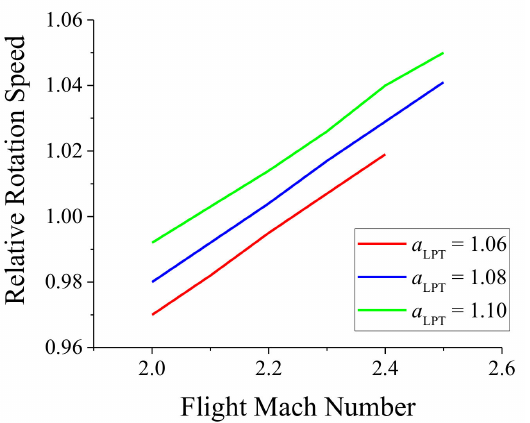
Figure 37. The Variations of Relative Rotation Speed of High-Pressure Shaft at the conditions of Different Throat Area Coefficients of Low-Pressure Turbine Inlet Guide Vane ( α LPT ).